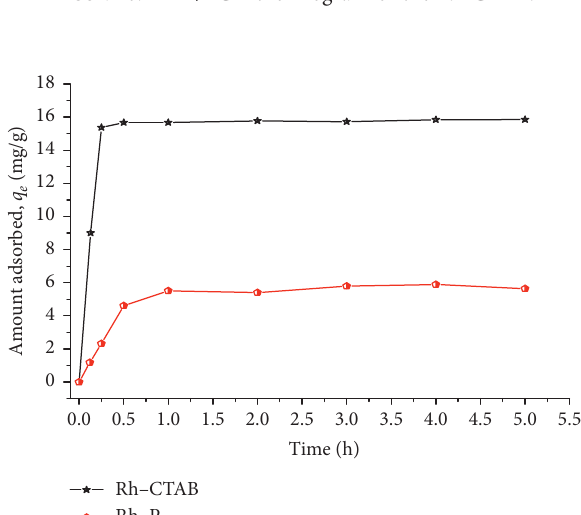
Figure 6: DTA/TGA thermogram of the Rh-CTAB.